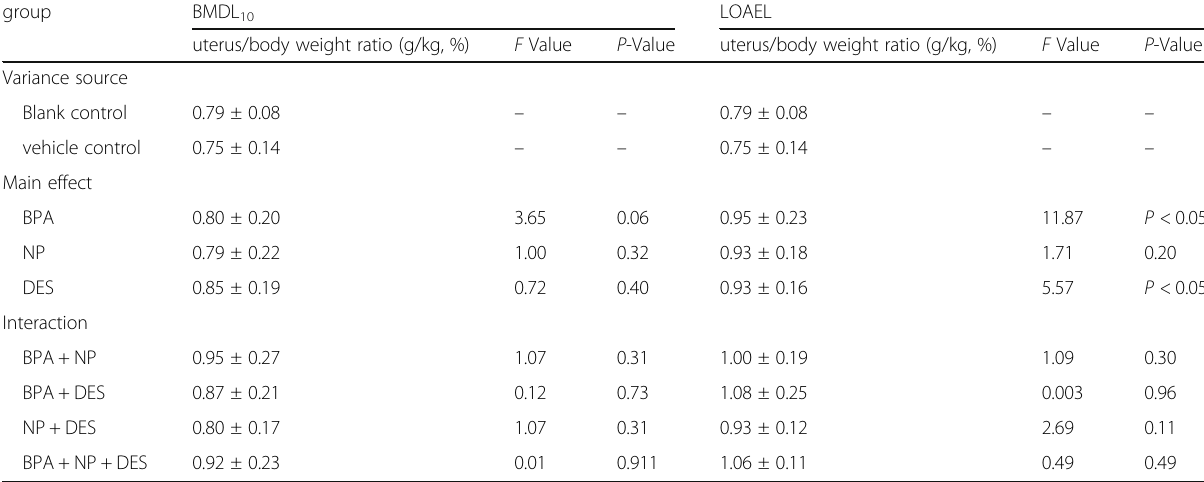
Table 2 Results of factorial analysis for the relative weight of uterus treated with combination of BPA,NP and DES( n = 10) group